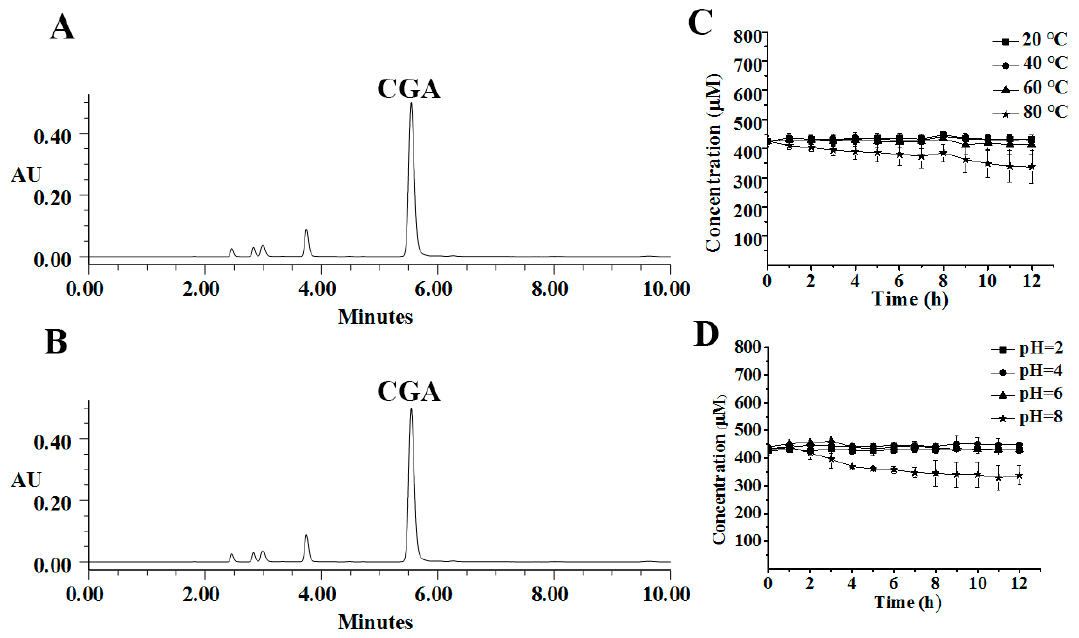
Figure 1. UPLC representative chromatograms of trans -caffeoyl-6- O - D -gluconic acid (CGA) in the exposed solution at 80 °C ( A ) and pH 8 ( B ) after 12 h; Time–concentration curves of CGA at different temperatures ( C ) and pH values ( D ).